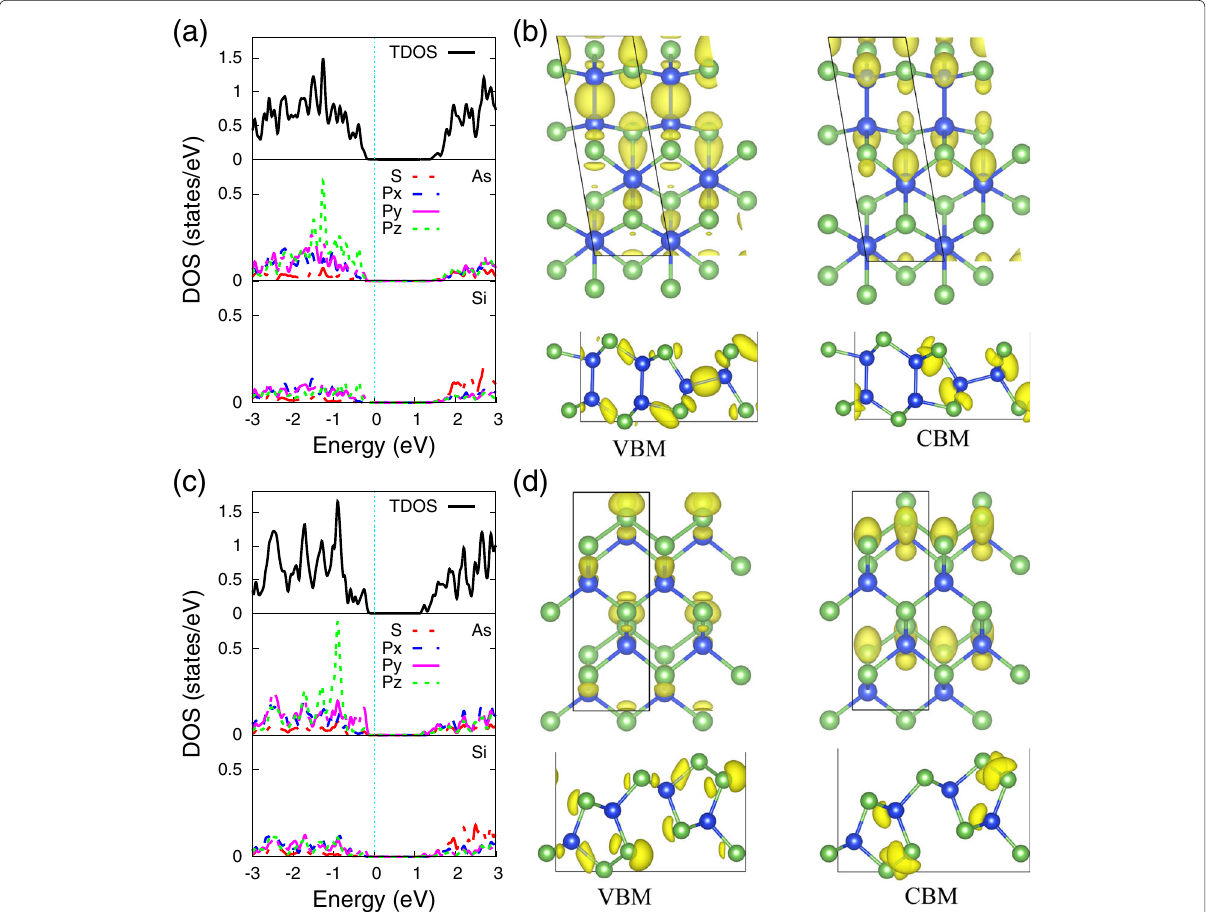
Fig. 4 Projected density of states and VBM and CBM’s electron density. The projected density of states (PDOS) of As and Si atoms and the electron density distribution corresponding to VBM and CBM of ( a , b ) SiAs and ( c , d ) SiAs 2 monolayers. The isosurface value 0.034 e / Å